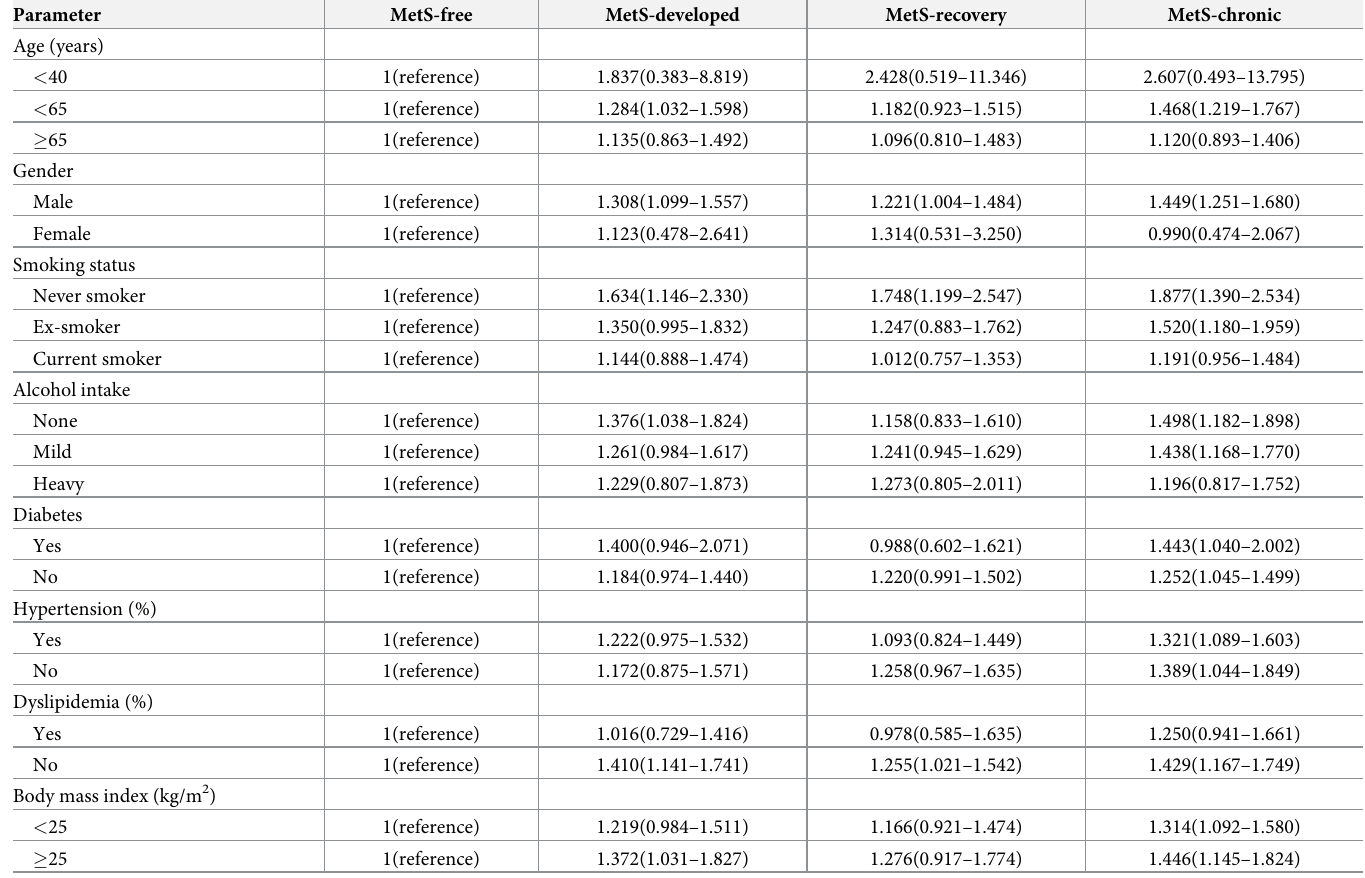
Table 4. Analysis of factors potentially associated with laryngeal